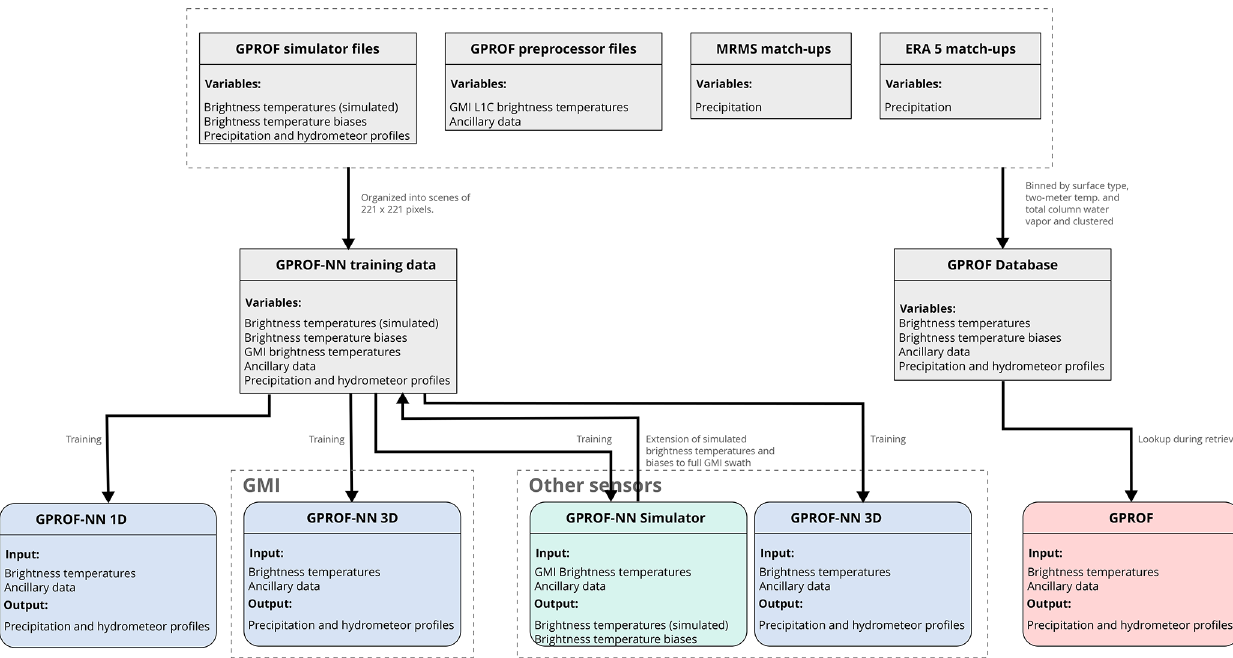
Figure B1. Data flow diagram for the generation and organization of the GPROF-NN training data. Grey rectangles represent datasets, and colored rectangles with rounded corners represent